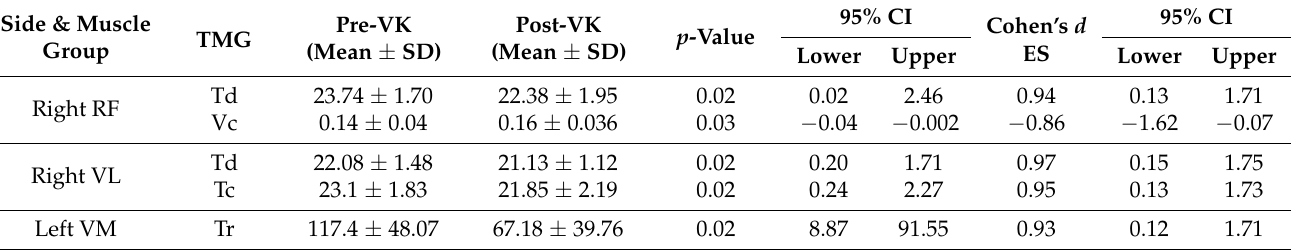
Table 3. Peripheral fatigue before and after the VK trail running race for each